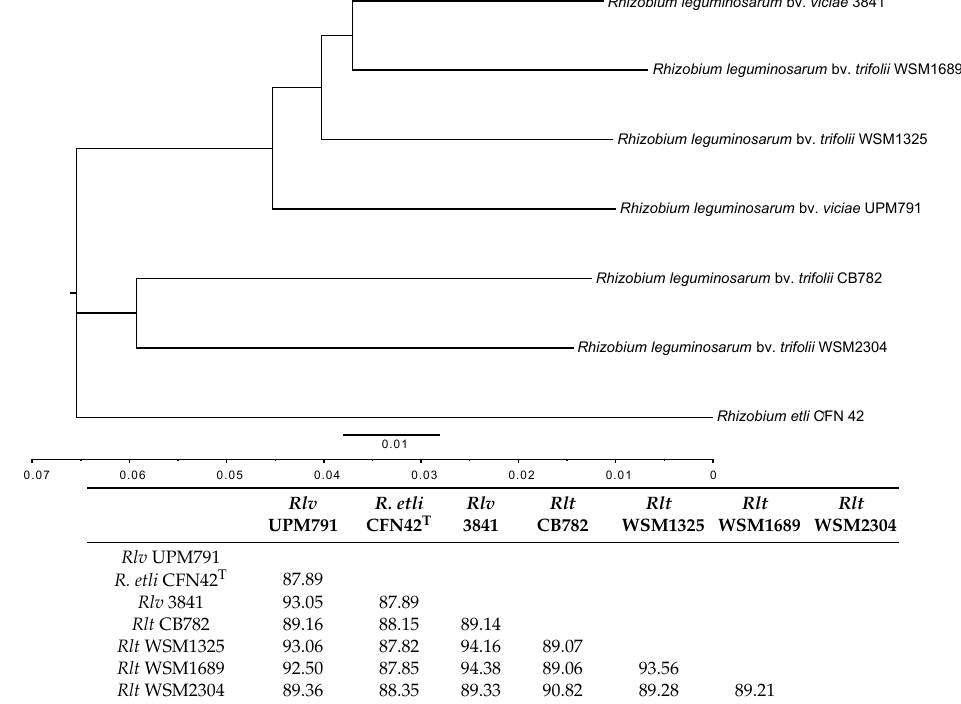
Figure 2. Average nucleotide identity MUMmer algorithm (ANIm) analysis. ANI-based UPMGA (unweighted pair group method with arithmetic mean) tree with the six representative R. leguminosarum genomes used in this study, using Rhizobium etli CFN42 T as the outgroup. The table below contains the ANIm values in